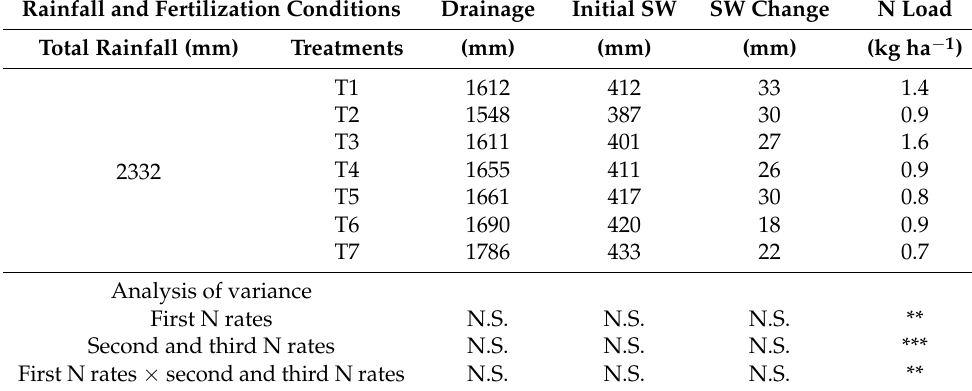
First N rates × second and third N